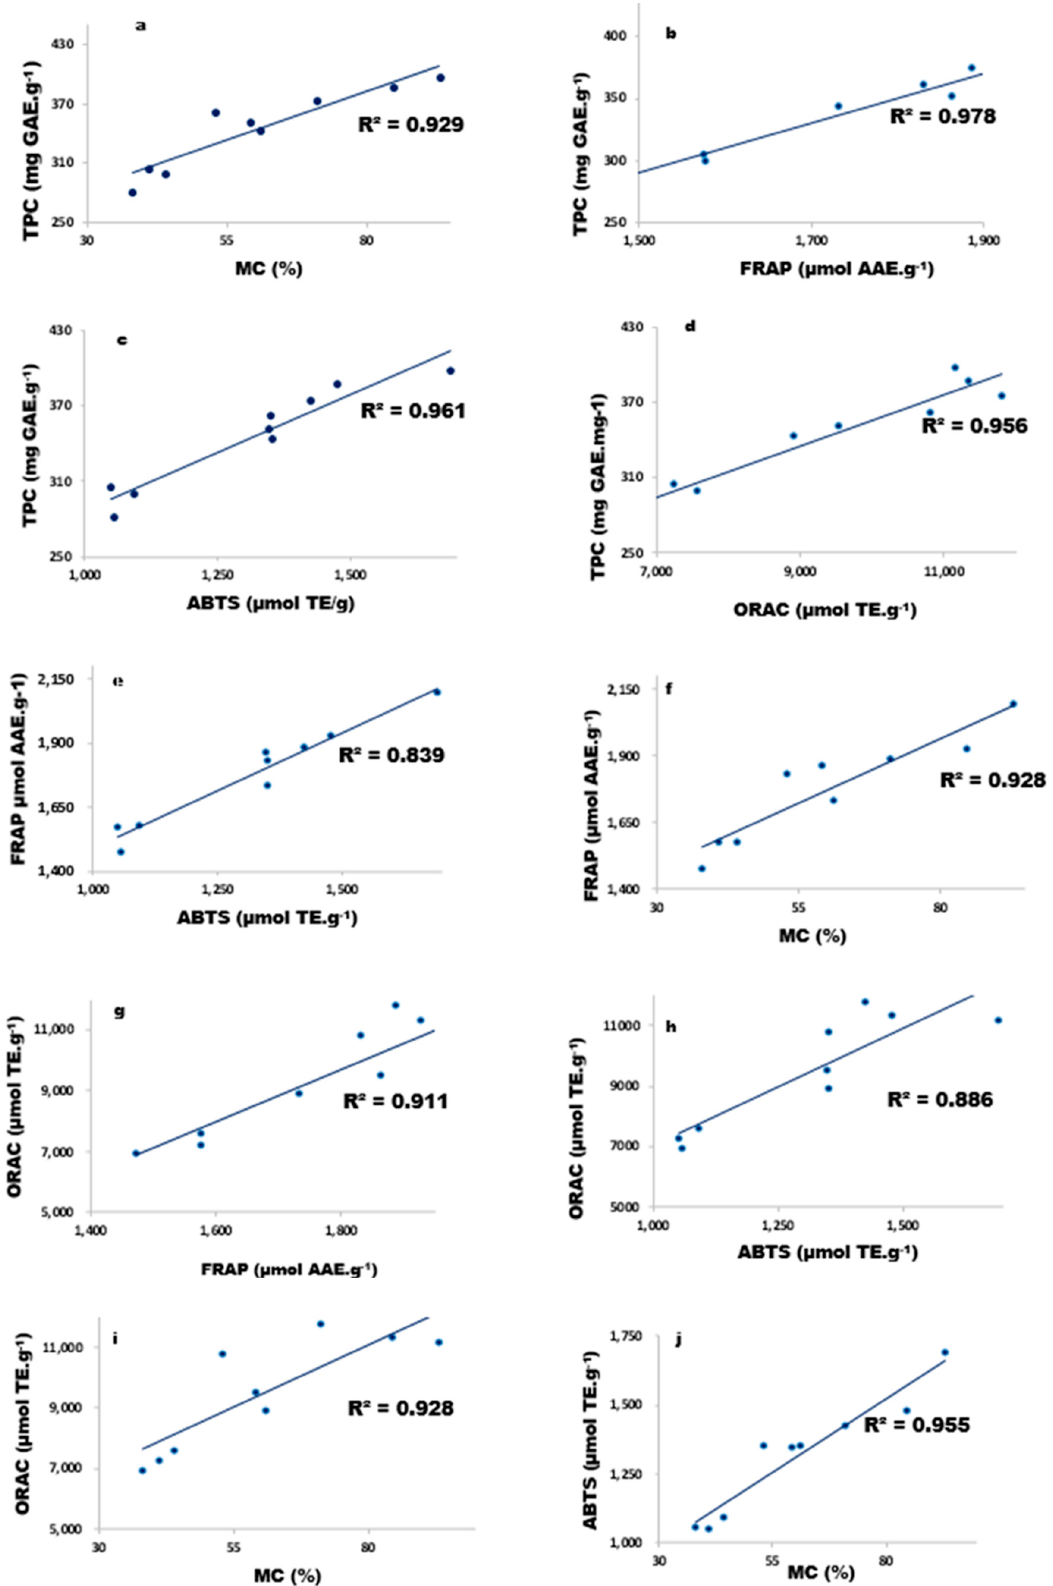
(Table 2). Moreover, significant solid positive correlations between response variables were ob- served, emphasising the effect of TPC on all antioxidant assays (Figure 1).